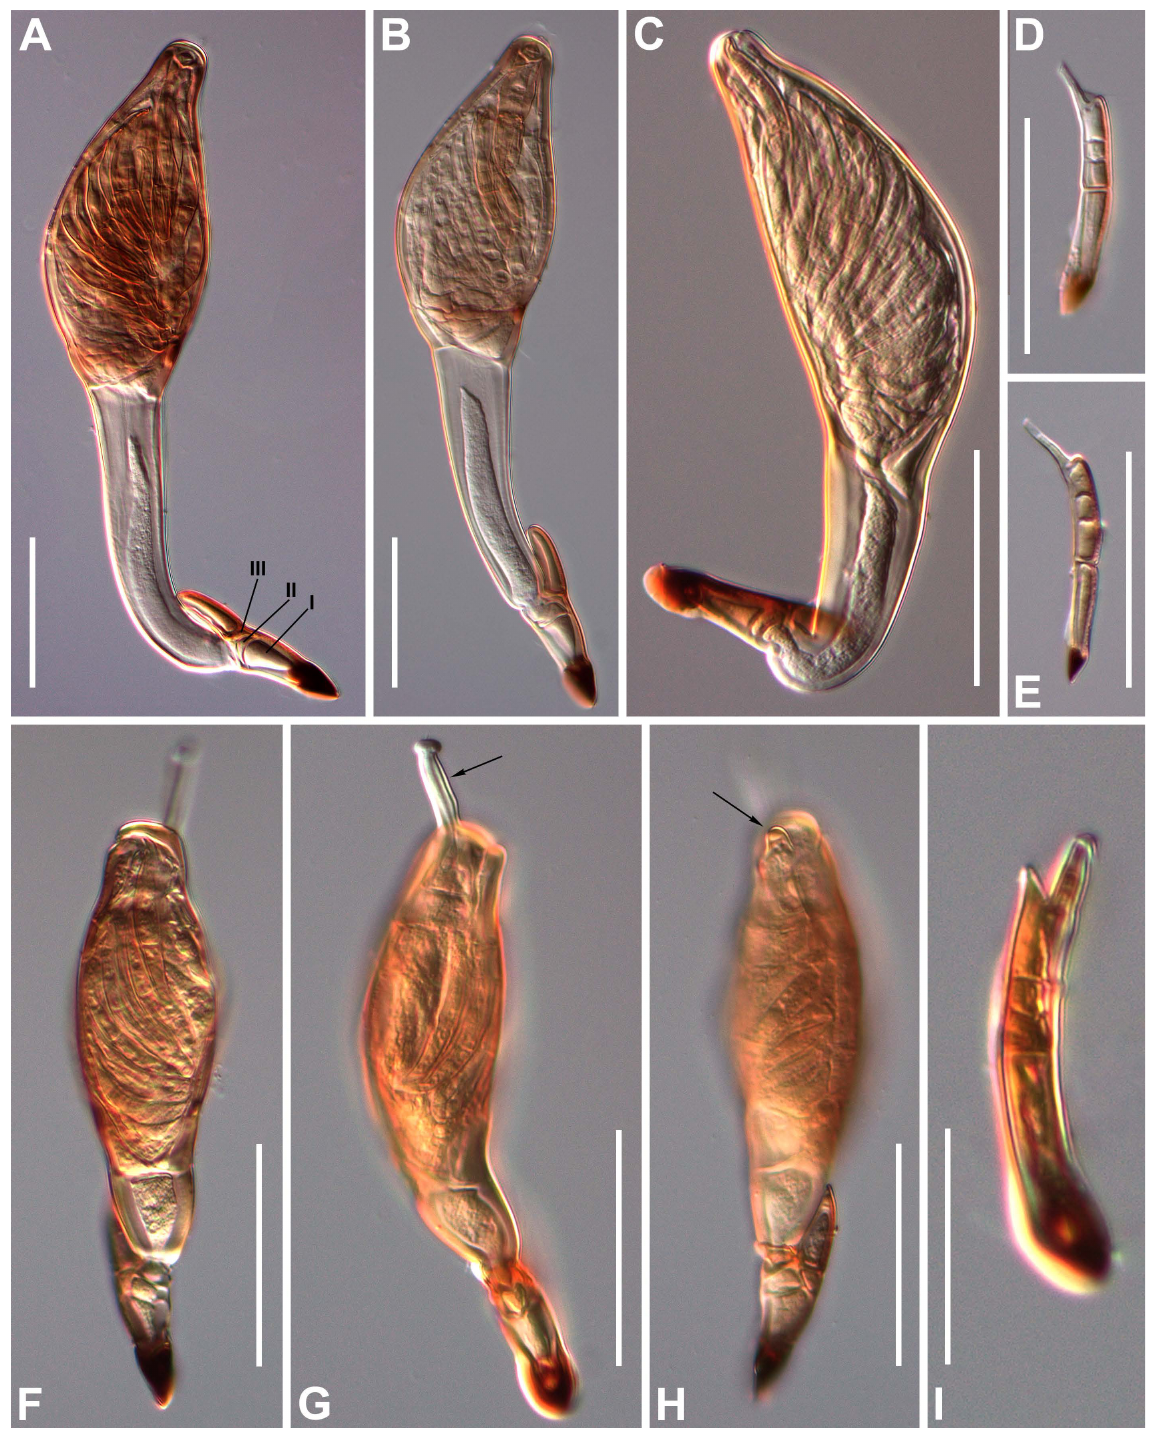
Fig. 66. Dioicomyces spp. A – E . D. anthici Thaxt. A – C . Mature female thalli. In A, cells I, II and III are labelled. D – E . Male thalli. – F – I . D. myrmecophilus T.Majewski. F – H . Mature female thalli showing a finger-like perithecial outgrowth in G (arrow), and a blunt prominence near the perithecial tip in H (arrow). I . Male thallus. Scale bars: A–H = 50 µm; I = 25 µm. Photographs from slides ZMUC C-F-123463 (A–B, D–E), ZMUC C-F-122537 (C), ZMUC C-F-122601